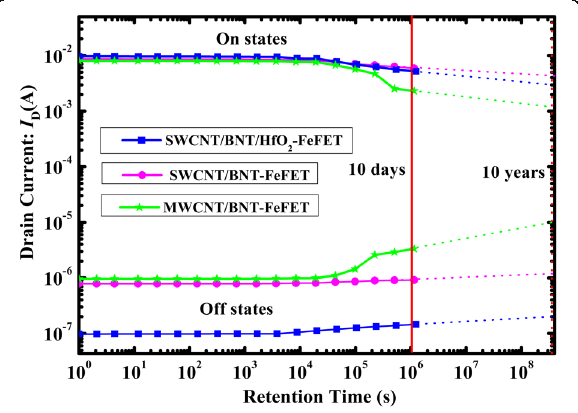
Fig. 7 Retention characteristics of the SWCNT/BNT/HfO 2 -FeFET, SWCNT/BNT-FeFET and MWCNT/BNT-FeFET at room